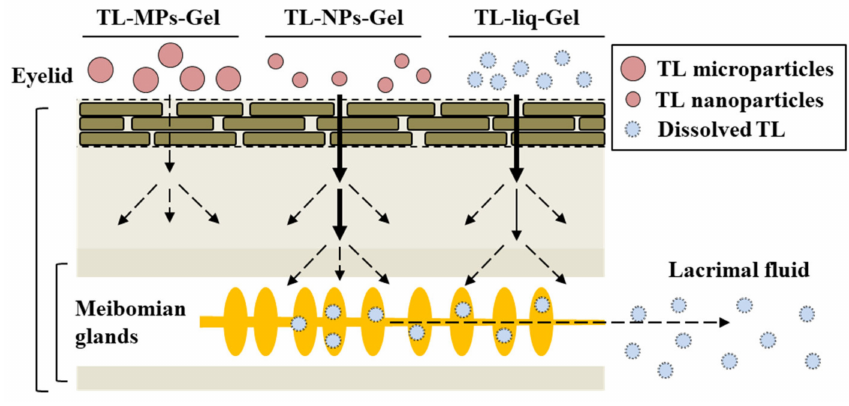
Figure 6. Ophthalmic drug delivery routes through the eyelid of TL